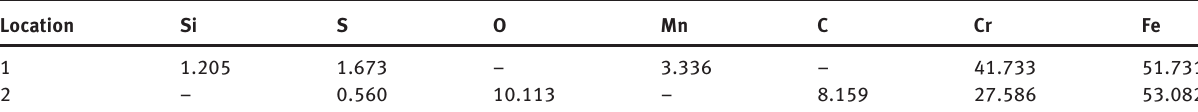
Table 2: Results of EDS analysis of 10% Cr specimens